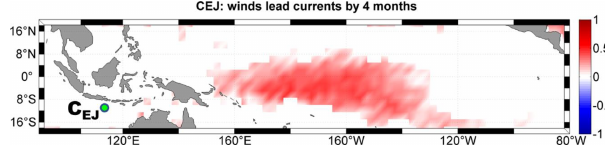
Figure 17. The same as Fig. 15 but at C EJ and for interannual